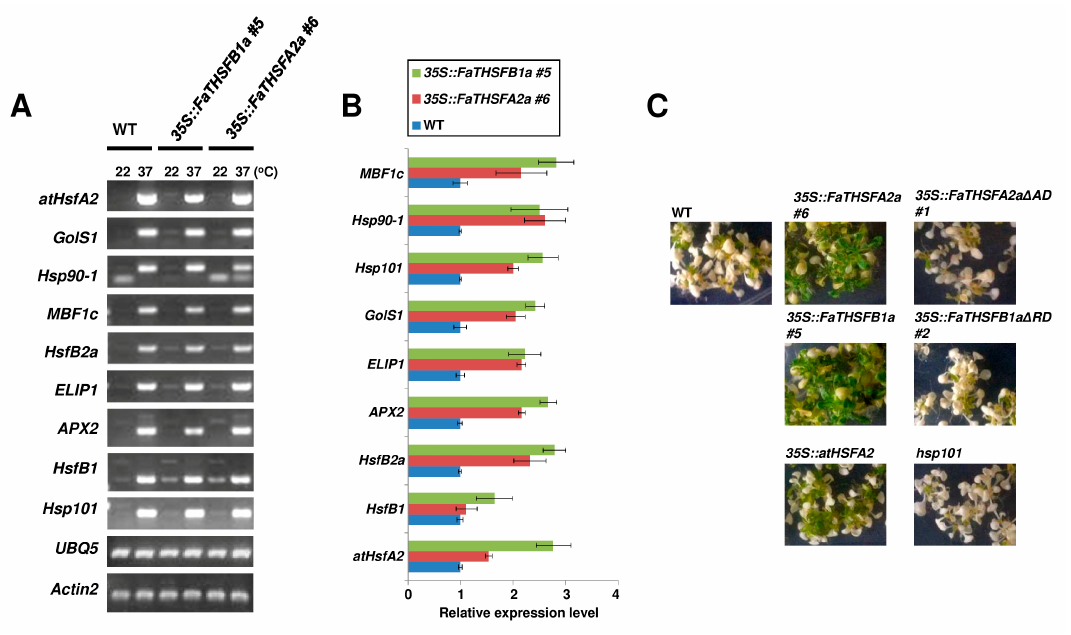
Figure 6. Roles of FaTHSFA2a and FaTHSFB1a in basal thermotolerance. ( A ) Up-regulated gene expression in 35S::FaTHSFA2a#6 and 35S::FaTHSFB1a#5 transgenic plants were observed after heat stress. Total RNAs were extracted from 10-day-old plants grown in MS medium at 22 °C and subsequently were either exposed to 22 °C as a control or moved to a 37 °C incubator for 1 h as heat stress treatment. The extracted RNAs were further used in semi-quantitative RT-PCR assays for wild-type (WT), 35S::FaTHSFA2a#6 , and 35S::FaTHSFB1a#5 plants by using gene-specific primer sets (Table S4). In this assay, Ubiquitin 5 ( UBQ5 ) and Actin2 ( ACT2 ) were used as the loading controls. Similar results were observed for 35S::FaTHSFA2a#4 and #5 and 35S::FaTHSFB1a#3 and #4 transgenic plants; ( B ) Analysis of mRNA levels in 10-days-old WT, 35S::FaTHSFA2a#6 , 35S::FaTHSFA2a Δ AD#1 , 35S::FaTHSFB1a#5 , and 35S::FaTHSFB1a Δ RD#2 at 22 °C by using gene-specific primer sets (Table S4). The levels of mRNA were determined by real-time qRT-PCR, and normalized with Actin2/8 (=1). Error bars indicate the standard deviation ( n = 3); ( C ) Thermotolerance evaluation of positive transgenic Arabidopsis lines with the overexpression of FaTHSFA2a#6 , FaTHSFA2a Δ AD#1 , FaTHSFB1a#5 , and FaTHSFB1a Δ RD#2 . Ten-day-old WT and transgenic plants exposed to heat stress at 45 °C for 1 hour and subsequently recovered at 22 °C for 7 days were evaluated for their greening cultivars and photographed. More than 20 plants were analyzed in each experimental set ( n = 3). Similar results were observed from triplicate experiments.